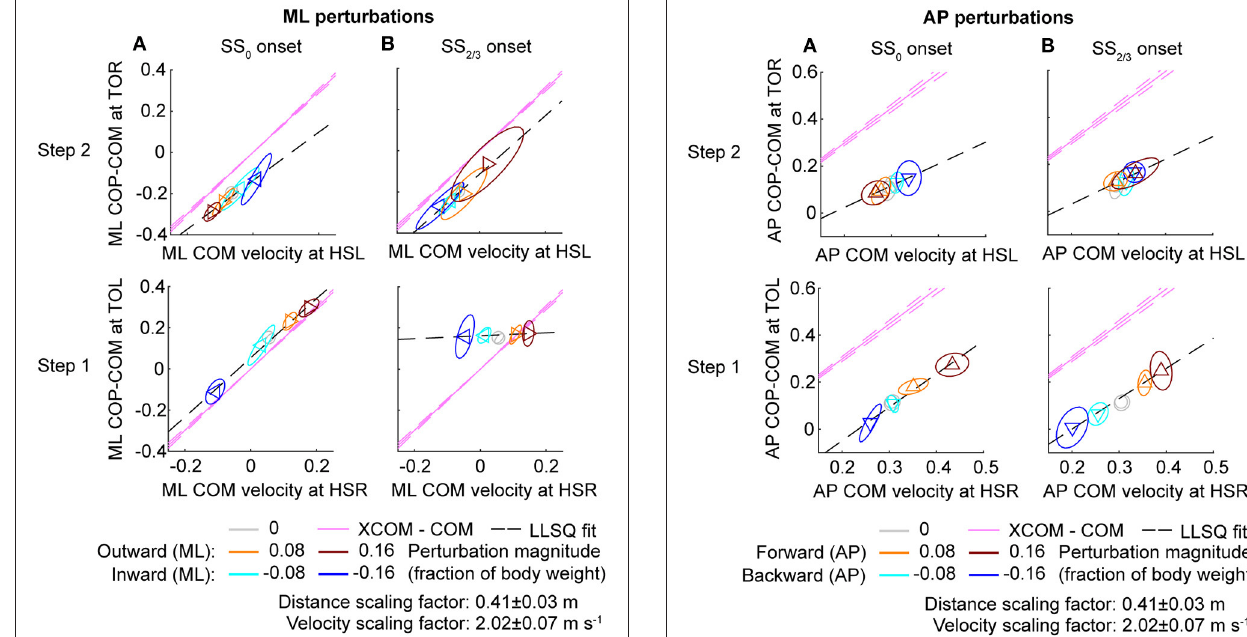
base of support corrections without making an actual step.